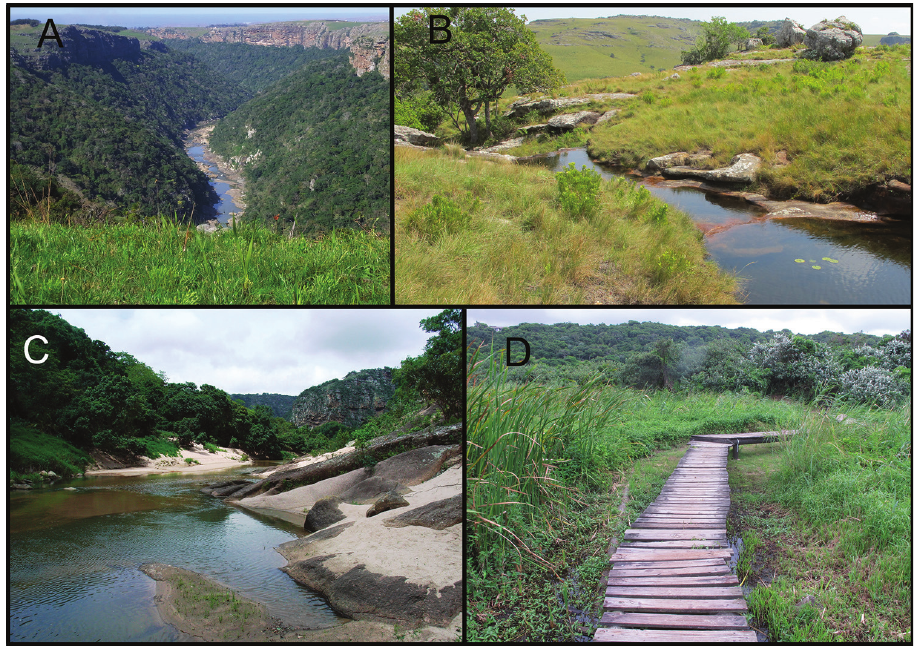
Figure 10. Habitat types of P. danielsi sp. n. Various habitat types of P. danielsi sp. n. A and B Mtam- vuna Nature Reserve showing the dense canopy cover under which specimens were collected as well as open streams and pools C Oribi Gorge Nature Reserve, and D Umhlanga Nature Reserve. Photos: A, B, C-Lynette Clennell; D-Nasreen